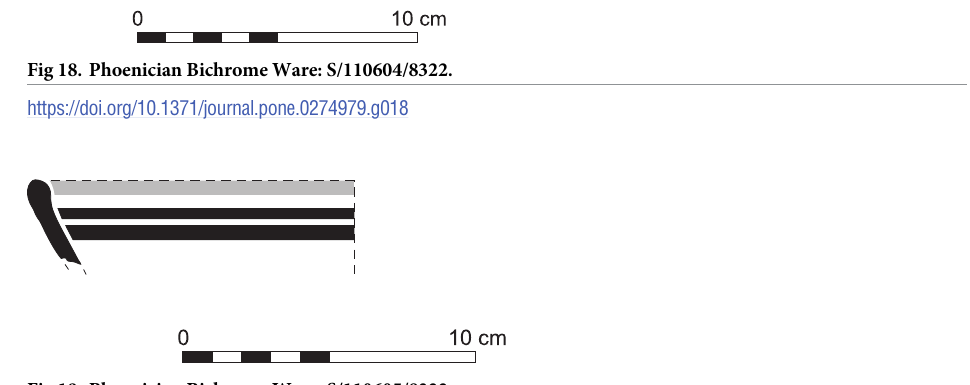
Fig 19. Phoenician Bichrome Ware: